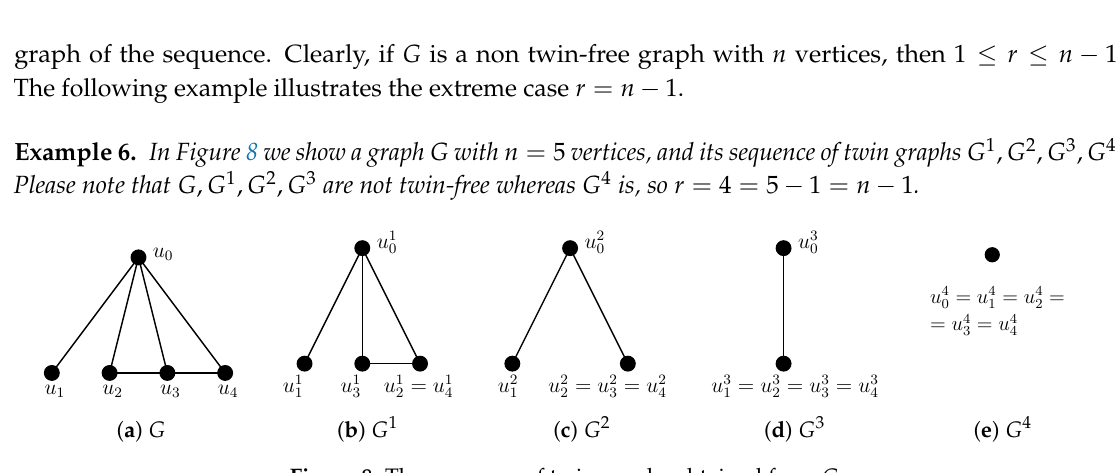
Figure 8. The sequence of twin graphs obtained from G